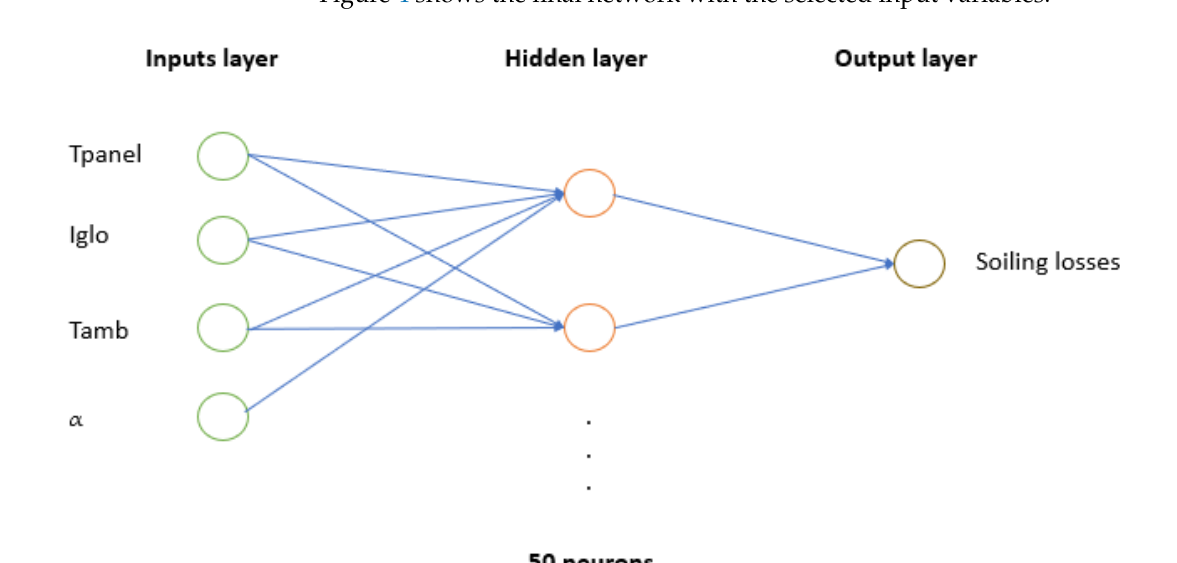
Figure 4. Final Model 1 network.